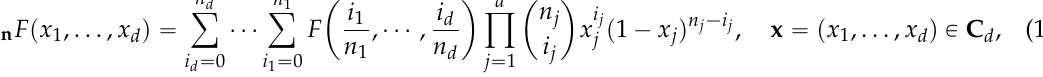
Table 3. Distribution of the vector X